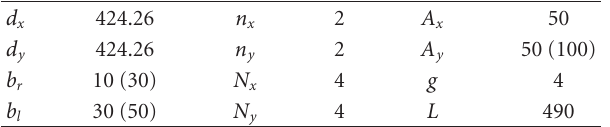
Figure 7: A fabricated TEM-wire fed parabola. Four ends of the TEM-wire horn are terminated by 150 Ω resistors to minimize return losses below 1